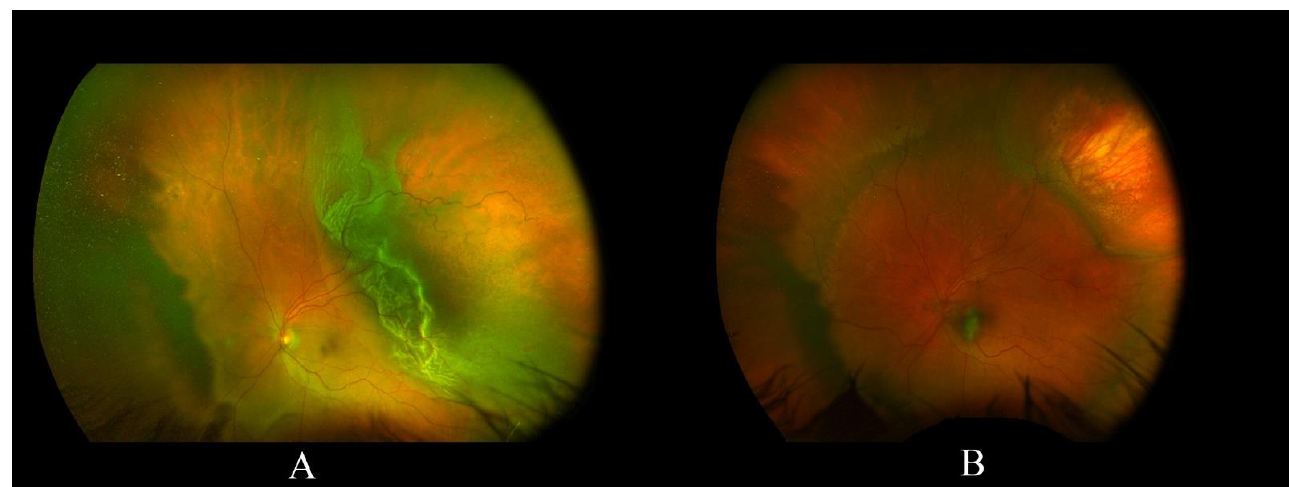
Figure 2. ( A ) a case of supero-temporal retinal detachment with an attached fovea; ( B ) following SB the retina is fully reattached, but a macular subretinal hemorrhage occurred.